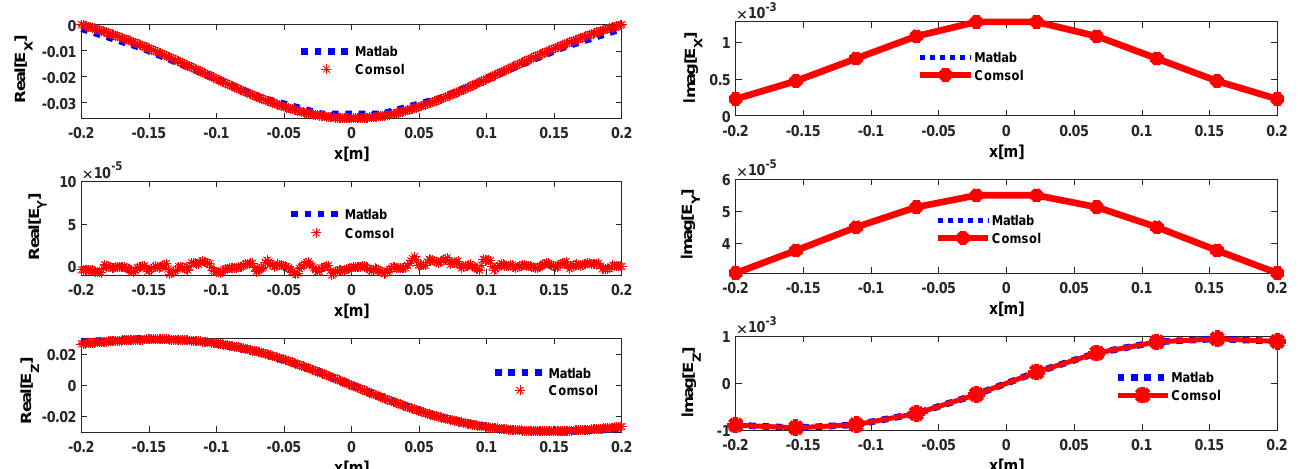
Figure 4. Real part ( left ) and imaginary part ( right ) of the scattered electric field by two PEC spheres. In particular, Matlab results (blue color dot lines) are perfectly super-imposed on Comsol results (red marker color lines). Sphere I and sphere II are translated at 0.5 m and − 0.5 m along z -axis, and the selected frequency is f = 3 MHz.